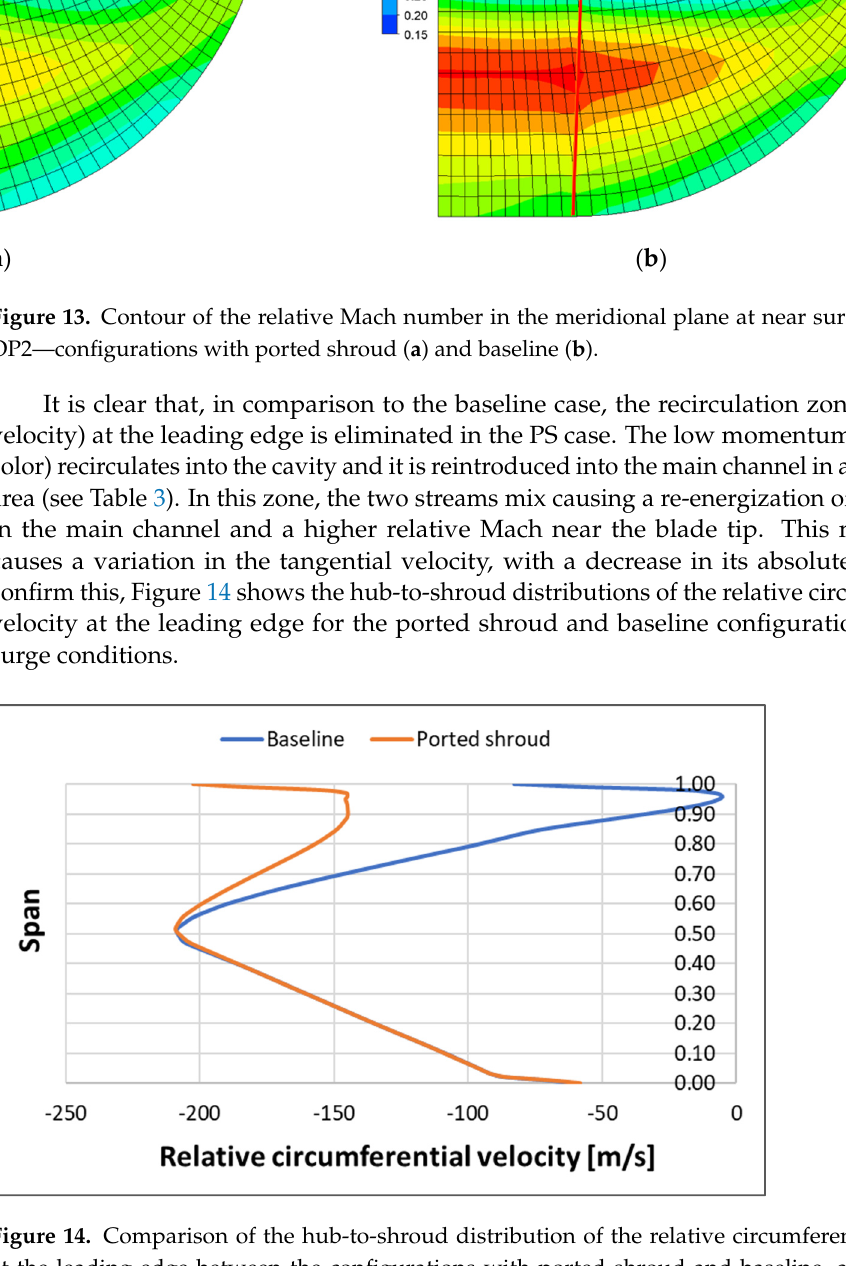
Figure 15. Comparison of the hub-to-shroud distribution of the relative flow angle at the leading edge between the configurations with ported shroud and baseline, at near surge condition OP2. It is clear that with ported shroud a larger span portion of the blade can work effi- ciently with respect to the baseline case; there is a reduced portion of incoming flow stalled. This is the main mechanism that leads to the stability limit extension in the ported shroud case, allowing the compressor to operate in a stable condition at or a lower mass flow rate. For the best efficiency condition, a recirculating flow from the cavity is also